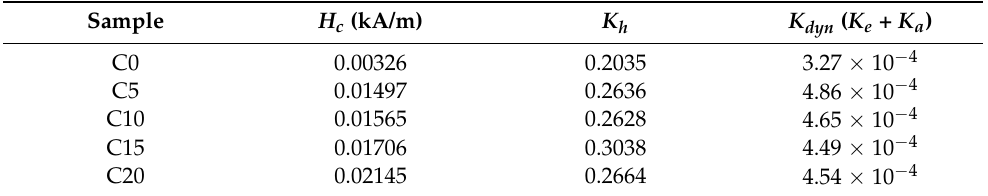
Table 2. The coercive field ( H c ) and derived hysteresis loss constant ( K h ) and dynamic loss